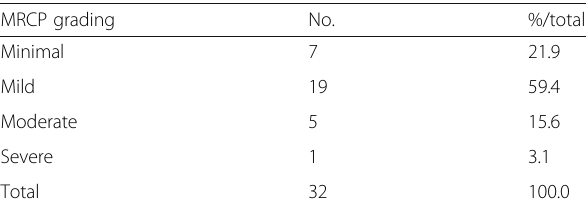
Table 3 MRCP grading of the biliary strictures in our studied cases